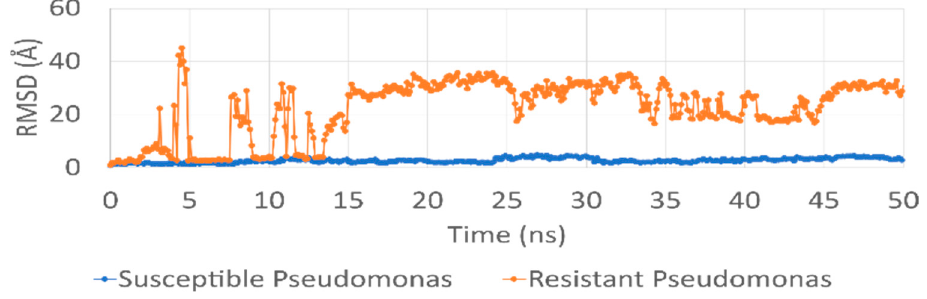
Figure 2. RMSD (root-mean-square deviation) between ∆ M2 peptide (one molecule) and Pseudomonas membrane models through 50 nanoseconds. Susceptible membrane system model and ∆ M2 peptide (blue line). Resistant membrane system model and ∆ M2 peptide (red